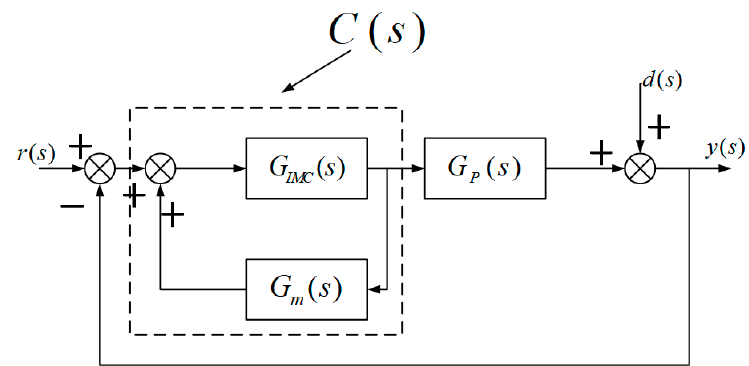
Figure 2. Design of equivalent internal model control structure.